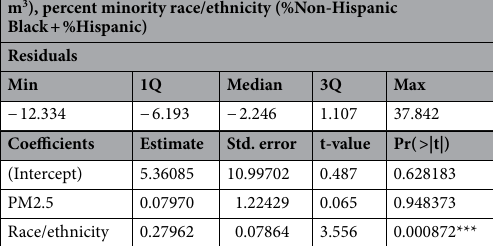
Multivariate linear regression of PM2.5, race/ethnicity, and COVID deaths for the 50 most Populous counties in Texas Dependent variable: COVID deaths Independent variables: PM2.5 (2000–2016 average in μg/ m 3 ), percent minority race/ethnicity (%Non-Hispanic Black + %Hispanic)